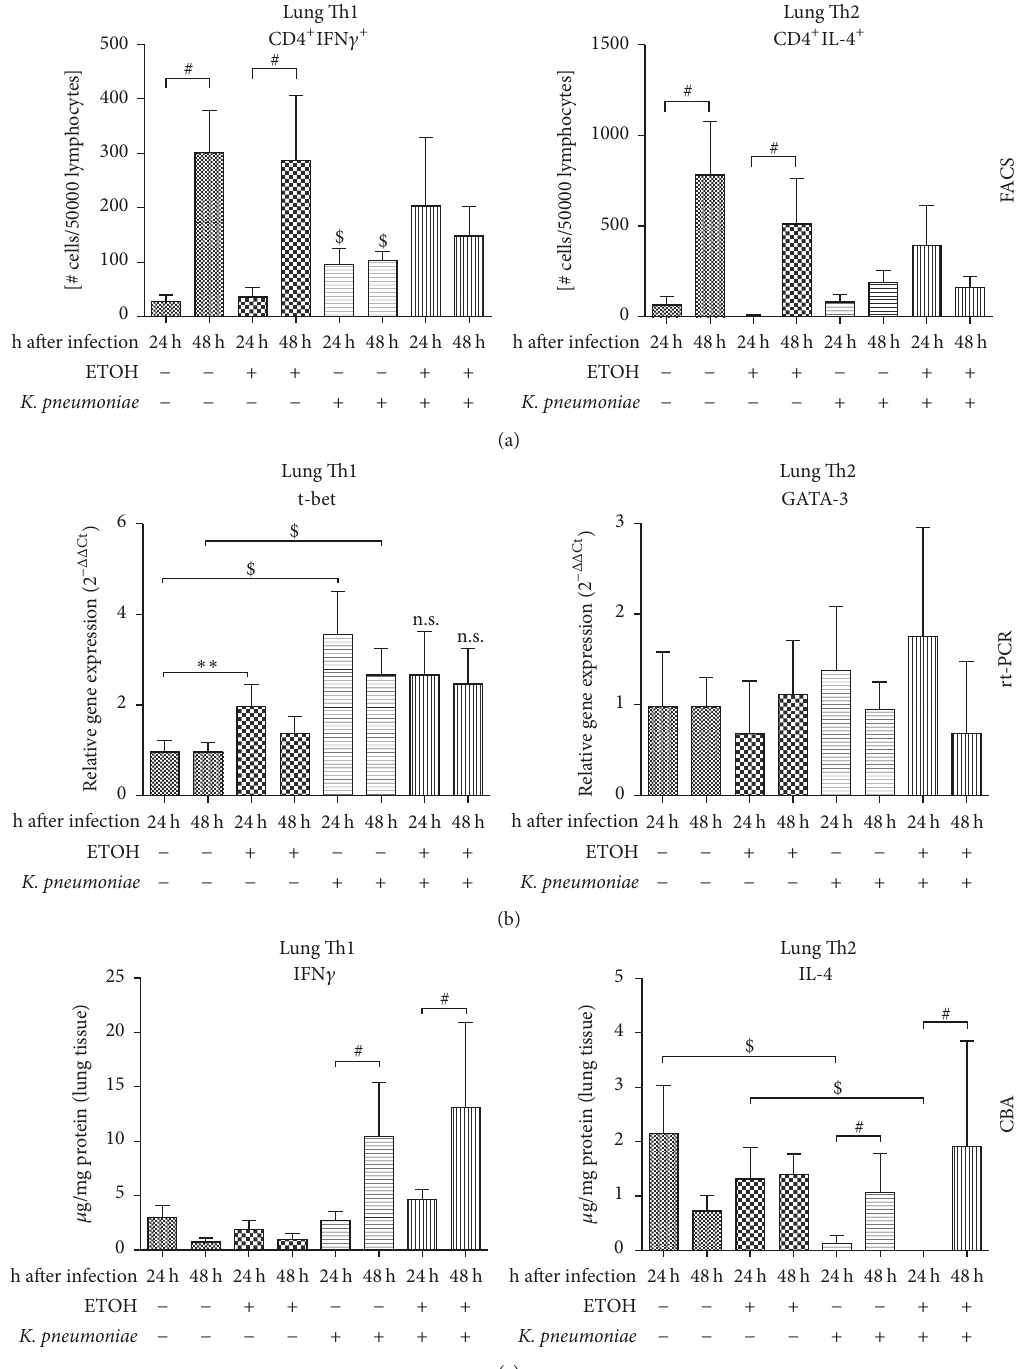
Figure 5: Flow cytometric analysis of indicated T helper cell subsets in the lung, relative gene expression of key transcription factors, and release of cytokine protein in a murine model of ethanol exposition for 2 weeks, surgery, and pulmonary infection. (a) Flow cytometric analysis of CD4 + /IFN- 𝛾 + cells (left) and CD4 + /IL-4 + cells (right) in the lung of ethanol-treated (ETOH) and saline-treated controls (NaCl) at 24 hours or 48 hours after pulmonary infection with Klebsiella pneumoniae . Cell counts are given as number of cells per 50.000 lymphocytes. (b) Transcriptional regulation of indicated transcription factors assessed by real-time polymerase chain reaction. Expression of 𝛽 -actin served as housekeeping gene; expression of controls was set to 100%. (c) Protein levels of indicated cytokines were analyzed by cytometric bead array (CBA) and given as 𝜇 g/mg protein of lung tissue. ∗∗ 𝑝 < 0.001 when comparing ethanol treatment and saline-treated controls at the